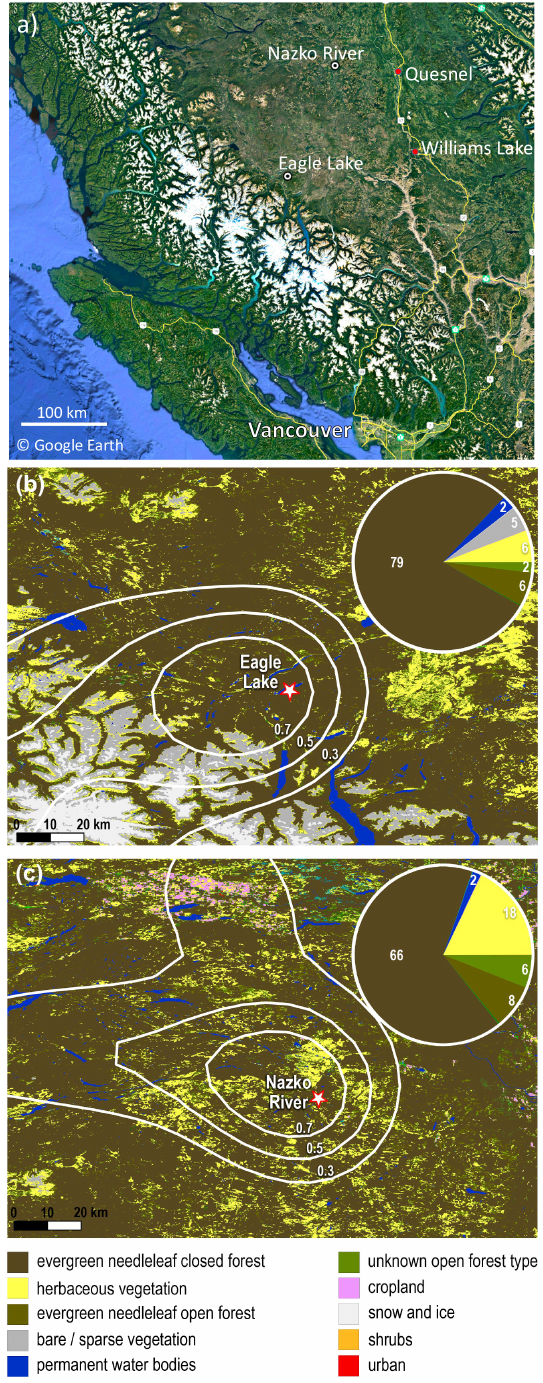
Figure 1. (a) Overview map of the sampling area (map base © Google Earth). (b, c) Land cover maps with backward trajectory densities, represented by 0.3, 0.5, and 0.7 contour lines, for Eagle Lake and Nazko River. The pie charts in panels (b) and (c) represent the land cover fractions (in %) for the areas within the 0.7 contour